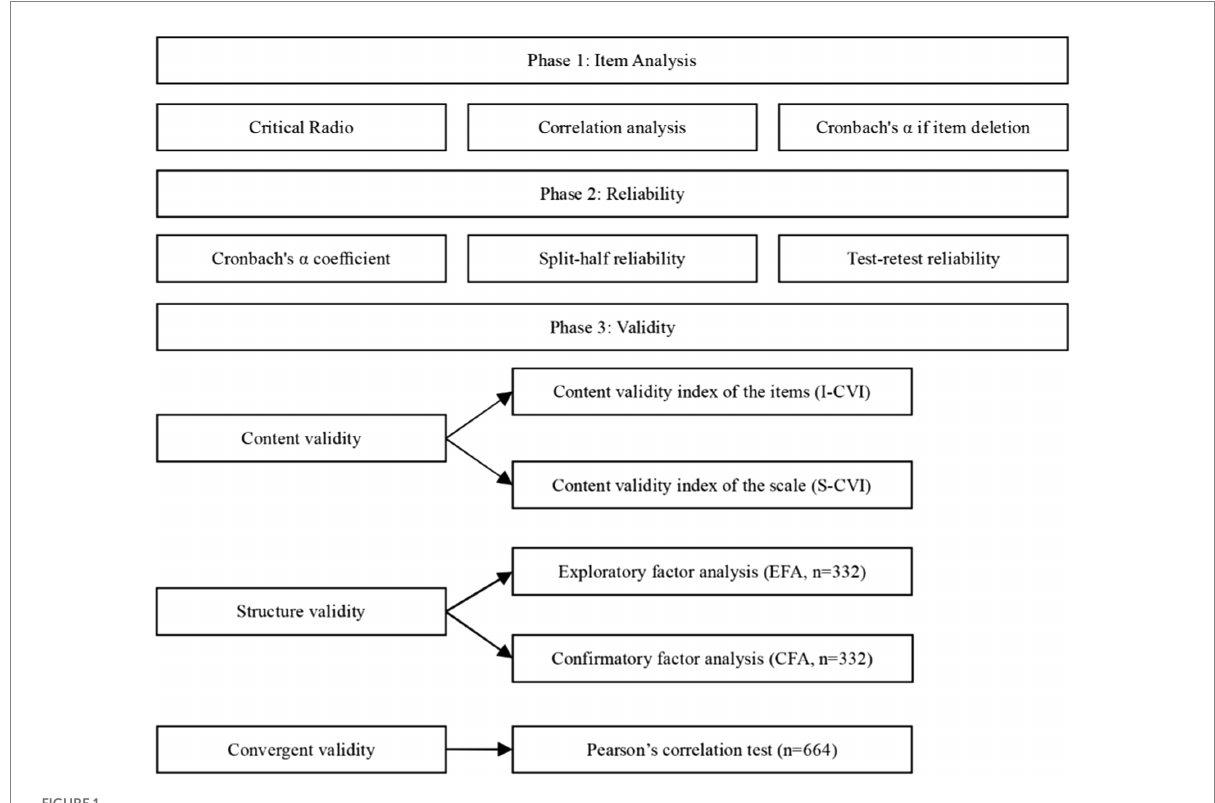
FIGURE 1 The data analysis procedure for Chinese version of the FH